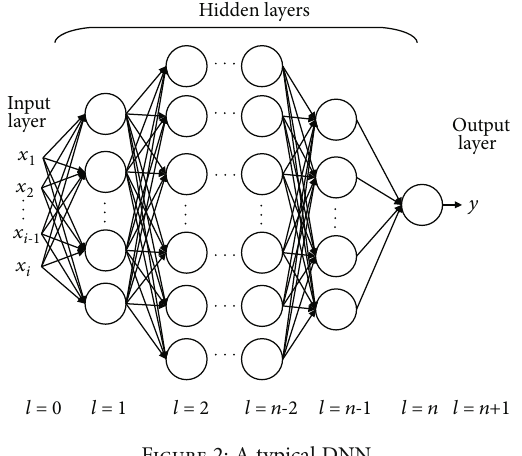
Figure 2: A typical